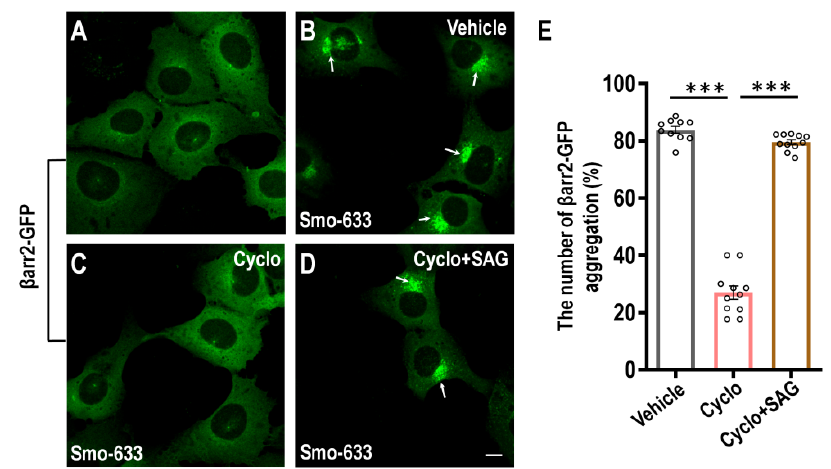
Figure 1. Establishment of the cell-based high-throughput screening assay and identification of novel Smo inhibitors. ( A – D ) The U2OS cells stably overexpressing β arr2-GFP alone ( A ); or with β arr2-GFP coexpressed with Smo-633 ( B – D ). Cells were treated for 24 h at 37 °C with DMSO vehi- cle ( B ), with 1 μ M cyclopamine (Cyclo) ( C ), or with 1 μ M Cyclo and 1 μ M SAG ( D ). The arrows show the intravesicular aggregation of β arr2-GFP. ( E ) The percentage of the number of β arr2-GFP aggregation was quantitated. The scale bar is 10 μ m. All data are means ± SEM (one-way ANOVA). *** p < 0.001.